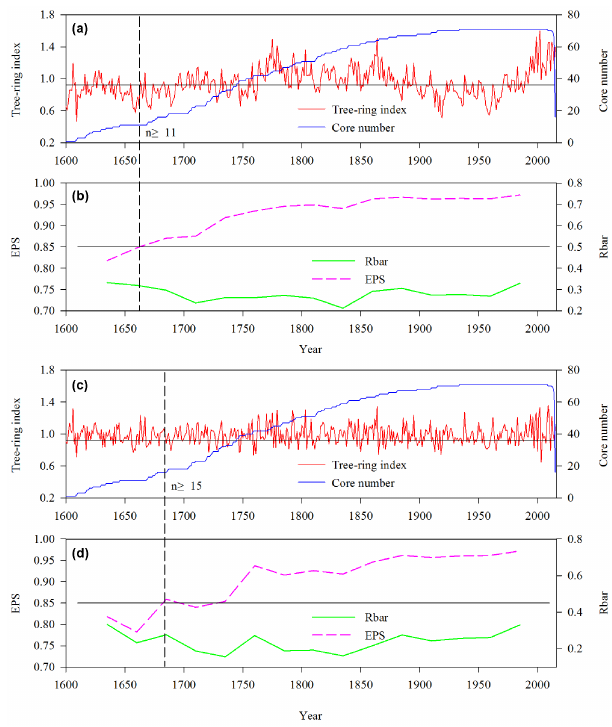
Figure 3. Variations of the std (a) and RES (c) chronology and sample depth and the expressed population signal (EPS) and aver- age correlation between all series (Rbar) of the std (b) and RES (d) chronology from AD 1600 to